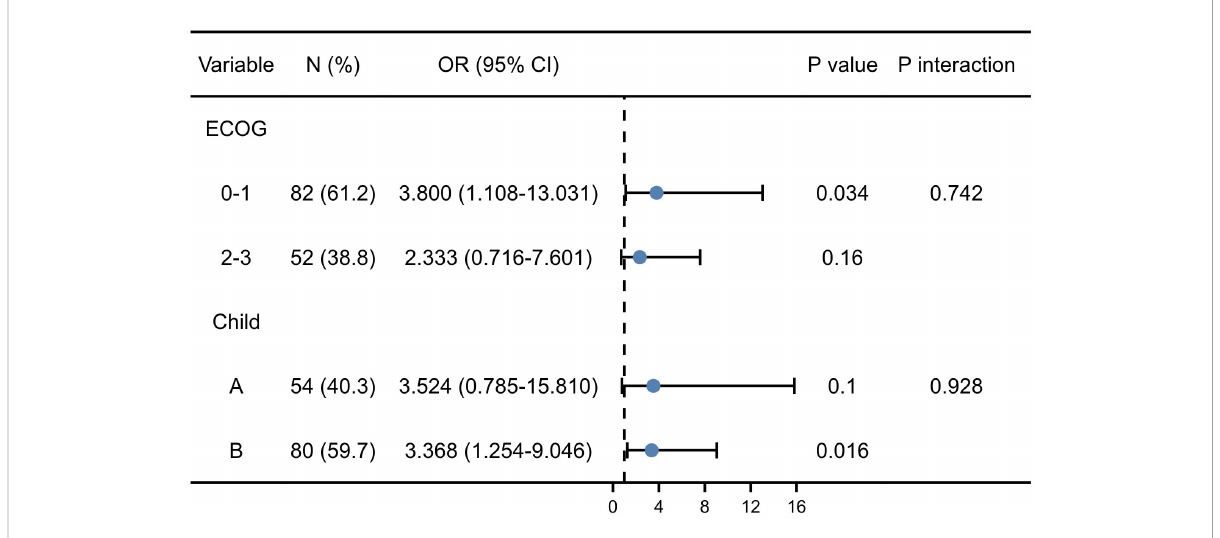
FIGURE 4 The forest plot of sarcopenia among ECOG and Child-Pugh score